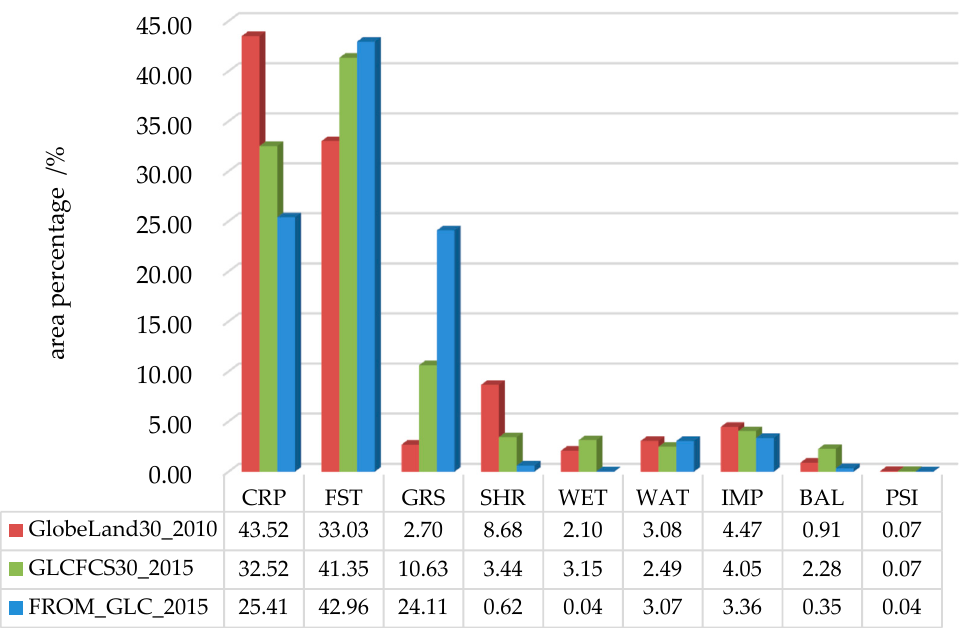
Figure 4. A comparison of area percentages of different target classes (CRP: cropland, FST: forest, GRS: grassland, SHR: shrubland, WET: wetland, WAT: water, IMP: impervious surface, BAL: bare land, and PSI: permanent snow/ice) in the three GLC products within the European Union (EU).